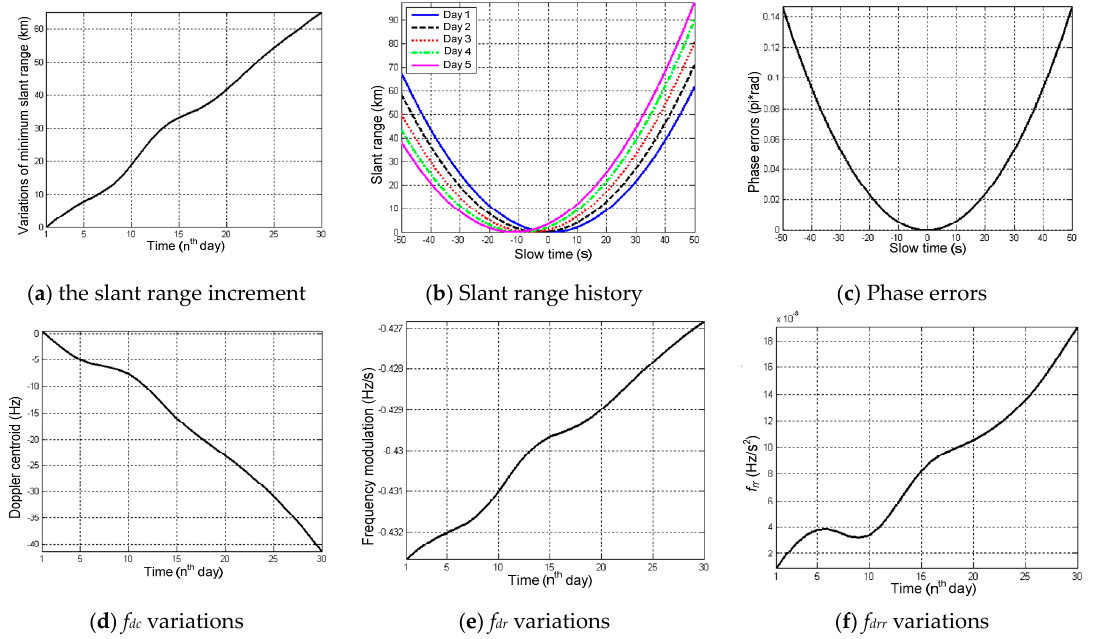
Figure 8. Variations of the slant range history and the Doppler coefficient (Doppler centroid: f dc , frequency modulation rate: f dr and third-order Doppler rate: f drr ) of the perturbed GEO SAR within one aperture at perigee.